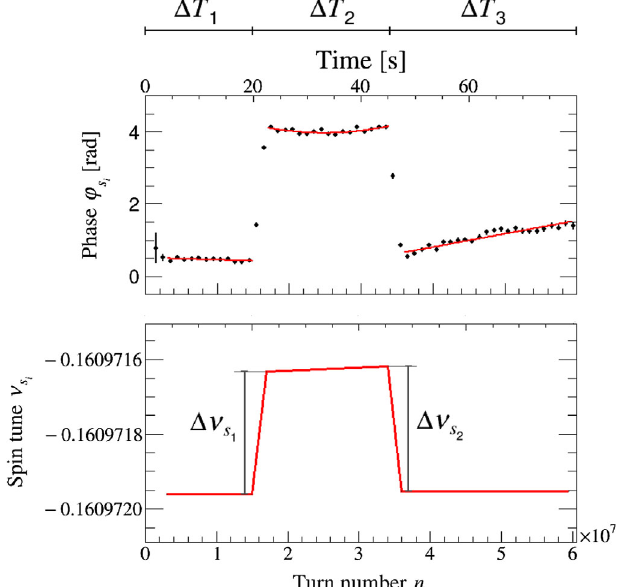
FIG. 12. Upper panel: Spin phase φ as function of the number s i of turns n for the three time intervals i ¼ 1 , 2, 3 of one particular cycle. In red, the fitted result using Eq. (D3) is indicated, exhibiting a pronounced nonlinearity in the time interval Δ T 2 . Bottom panel: Spin tunes ν , calculated using Eq. (D3), and spin s i tune jumps Δ ν , calculated from Eq. s 1 ; 2